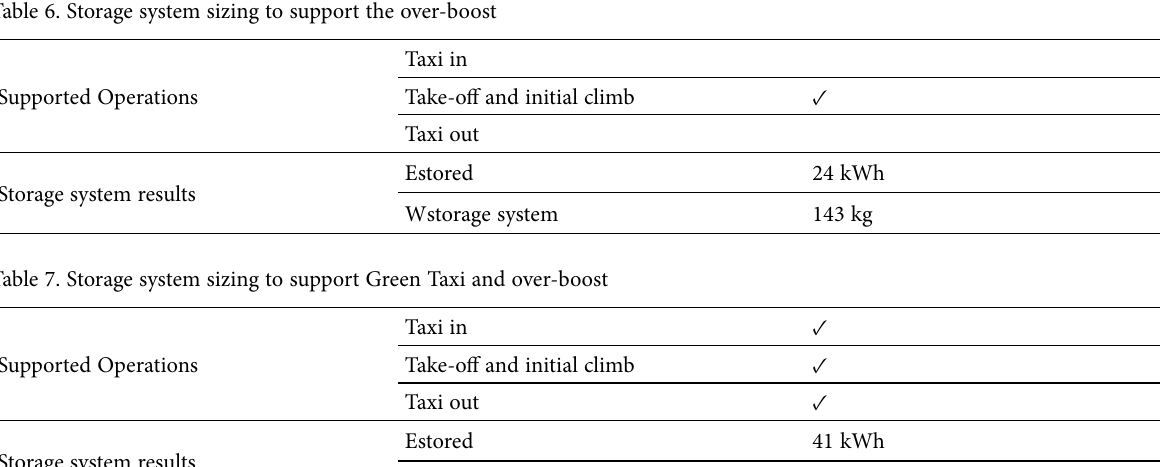
Table 6. Storage system sizing to support the over-boost